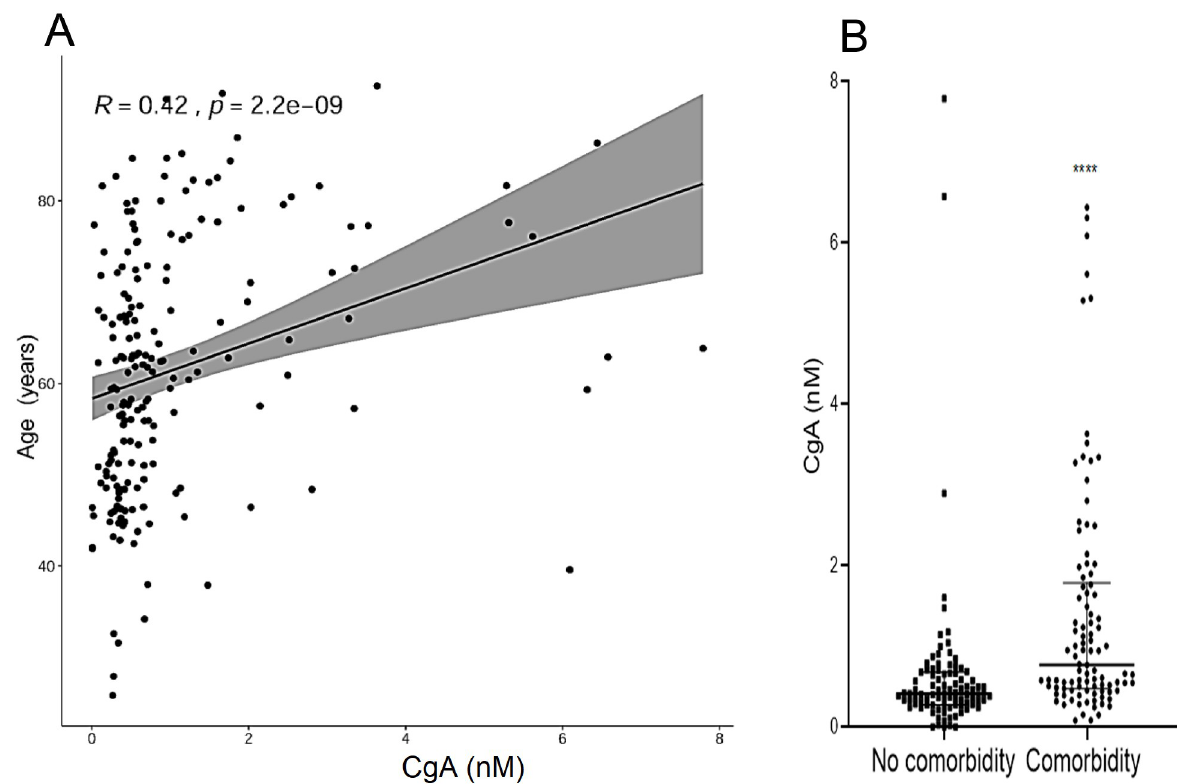
Fig 2. Panel A: Correlation of CgA plasma levels with age. Panel B: CgA plasma levels in patients with or without comorbidities. ��� < 0.0001.